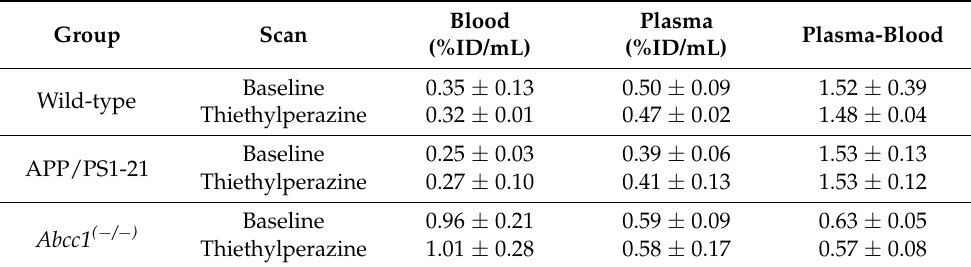
Table 3. Radioactivity concentrations (%ID/mL) in blood and plasma and plasma-blood radioactivity concentration ratios in the three mouse strains before and after treatment with